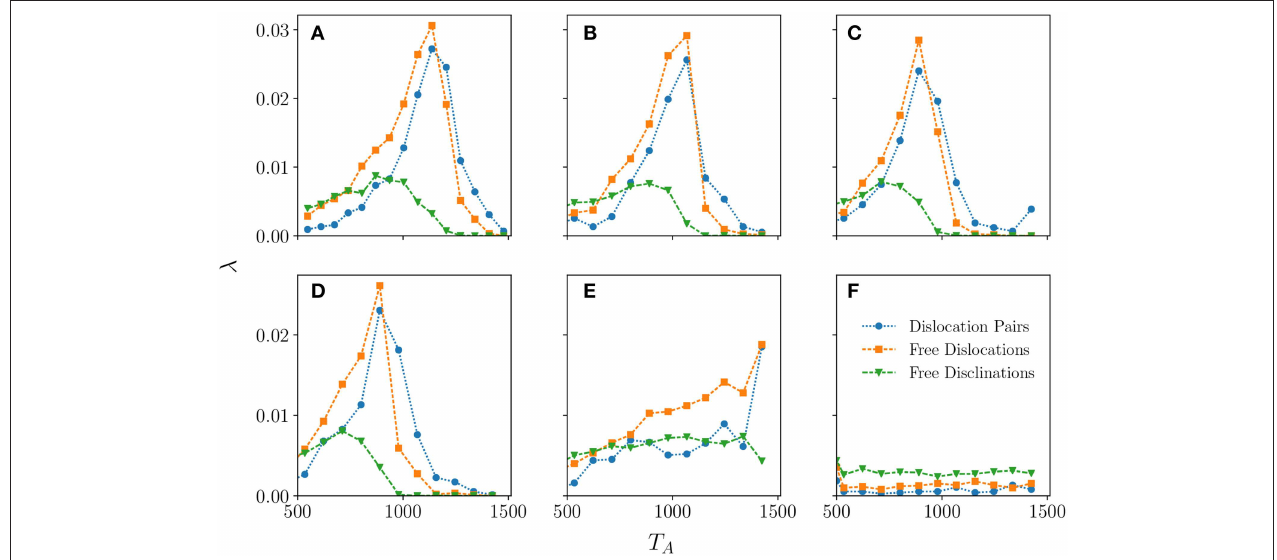
1,200 and ν 48. The absence = = 0.00, 0.15, 0.35, 0.55, 0.75, and 0.95. Defects with different number of neighbors = >1157